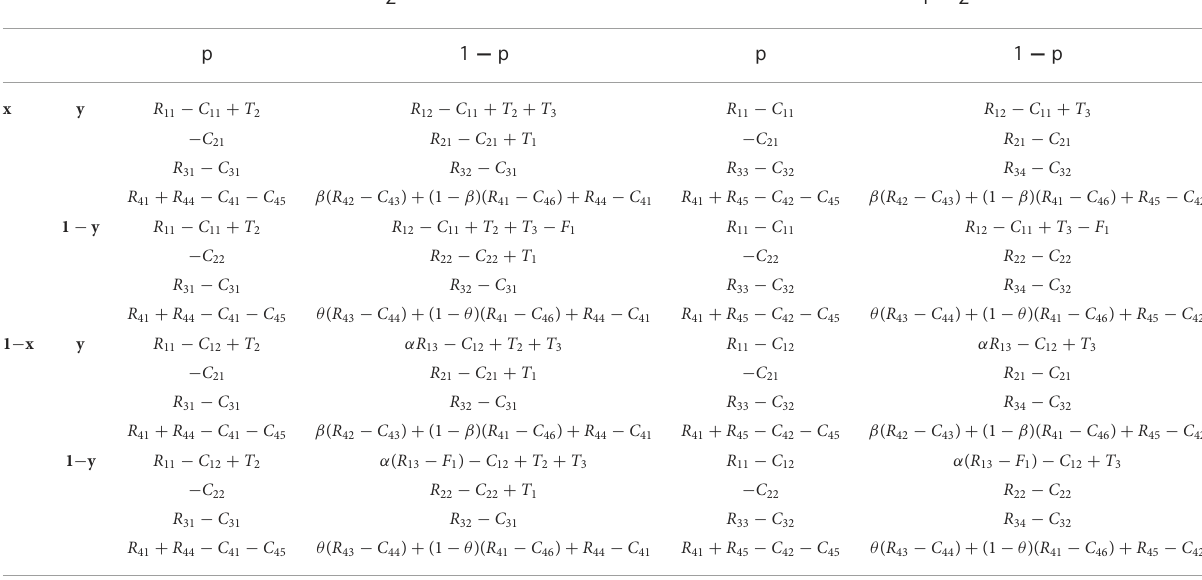
TABLE 2 Evolutionary game payoff